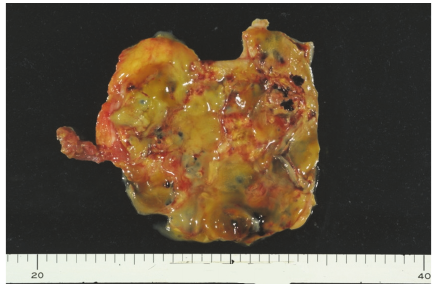
Figure 3: Abdominal wall mass removed at autopsy.